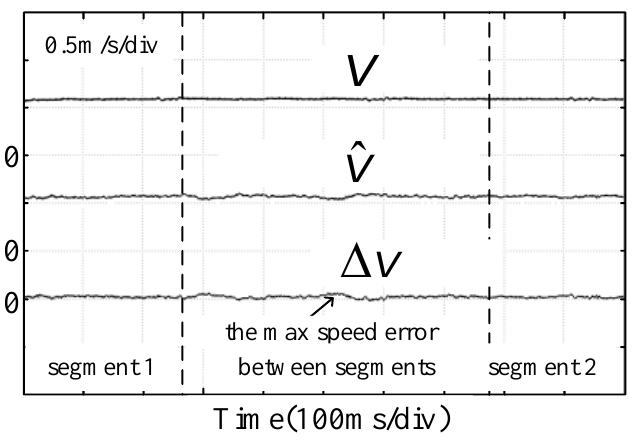
Figure 13. The speed estimation by the FSO.